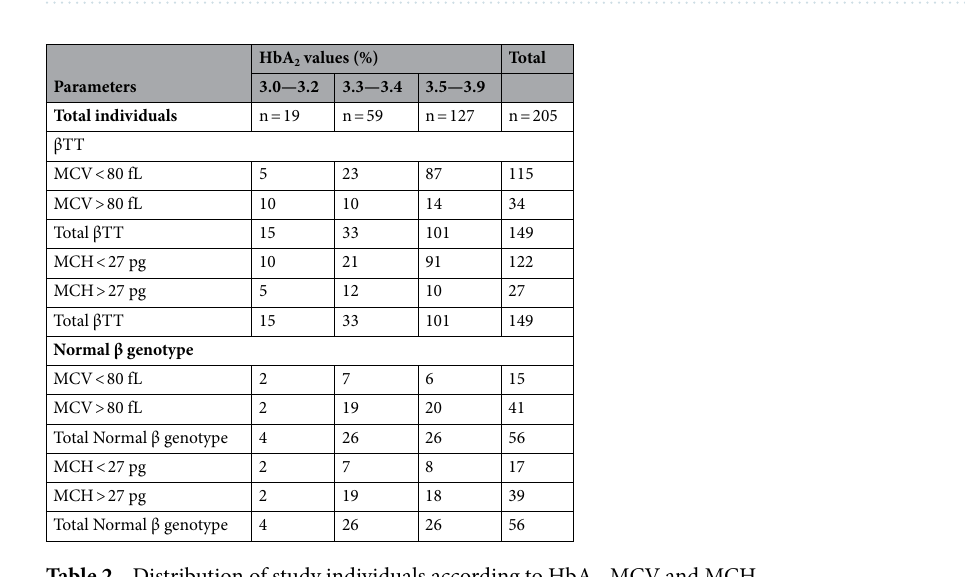
Table 2. Distribution of study individuals according to HbA 2 , MCV and